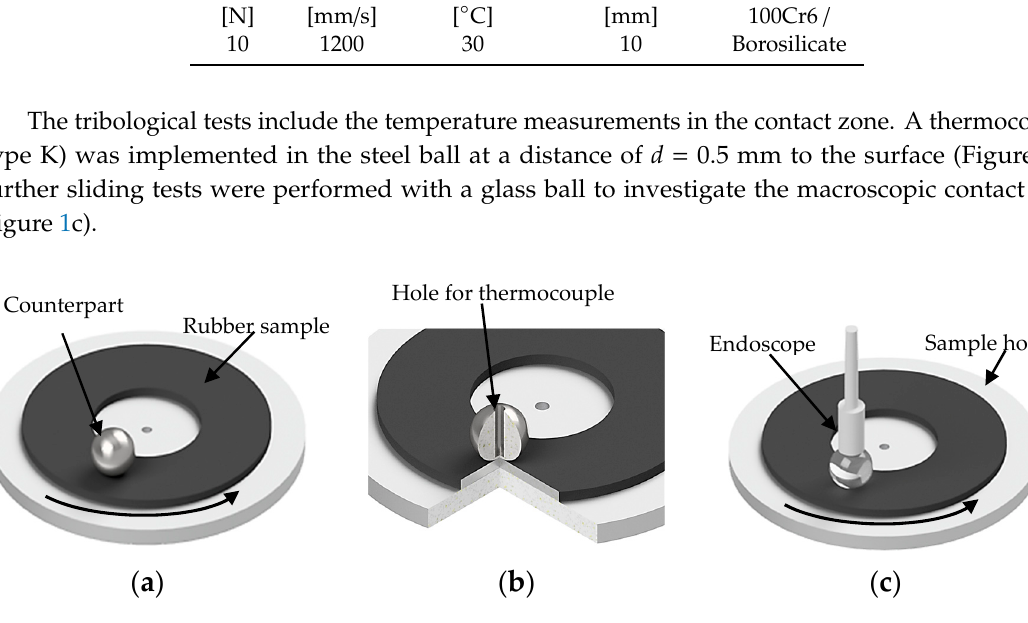
Figure 1. Scheme of tribological set-up: ( a ) configuration to measure CoF; ( b ) sphere with hole for temperature measurement; ( c ) configuration to measure the nominal contact area with glass ball.